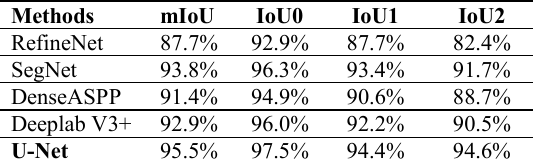
Table 2 . Performance comparison on the Validation dataset.